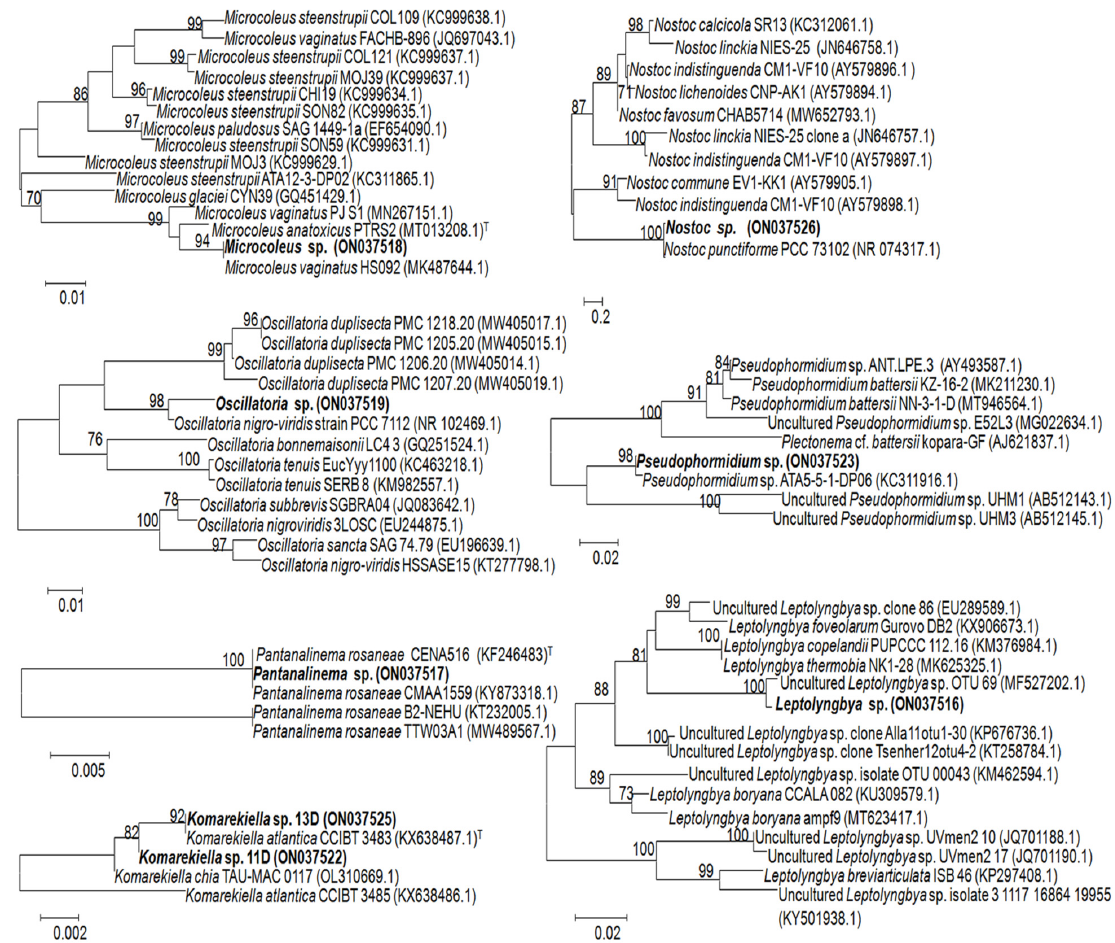
Figure 4. Neighbor-joining phylogenetic trees of orchid-associated cyanobacteria based on 16S rRNA gene sequence data showing the affiliation of predominant root-associated cyanobacteria. The reference samples were the 16S rRNA sequences from the NCBI database; GenBank accession numbers are given in parentheses. The significance level of branching into clusters is given as values, based on the bootstrap analysis. Numbers on the branches represent percentages of 1000 bootstrap replications. “T” indicates the type strain.